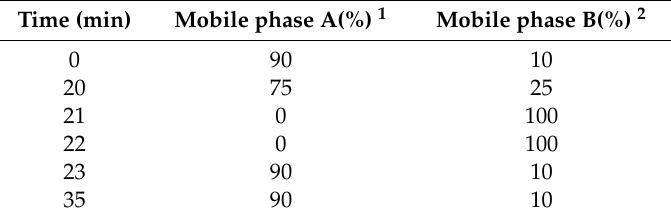
Table 1. Change of the ratio of the mobile phase according to the retention